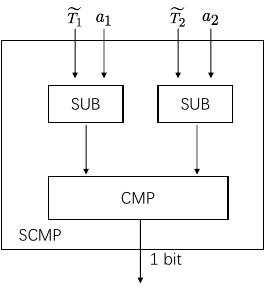
Figure 5. The SCMP circuit. Algorithm 3 The time-comparing circuit TC .